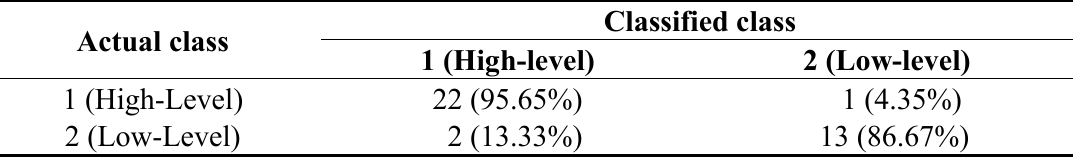
Table 4. RST-DEA-GP model (model I) results with both significant variables and DMU.